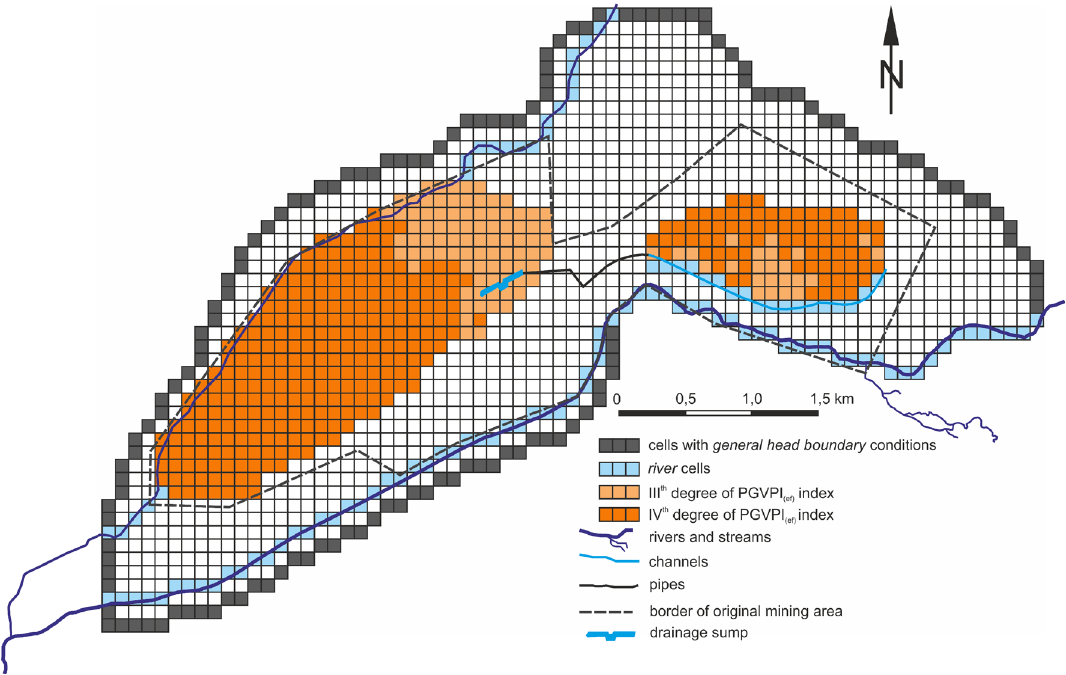
Fig. 8 Spatial distribution of the PGVPI